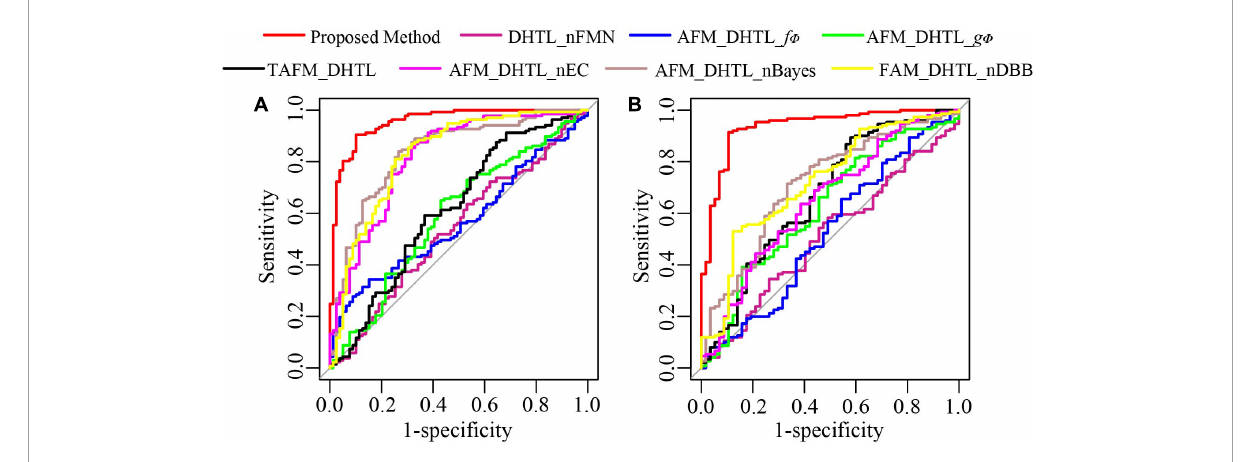
TABLE 5 The performance indices of the proposed method and seven contrast models.